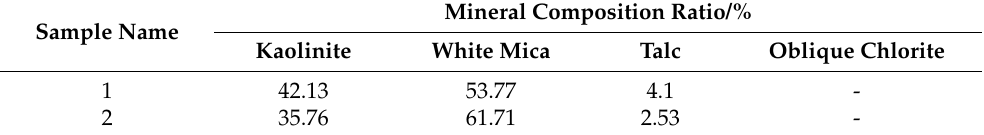
Table 2. Composition of clay